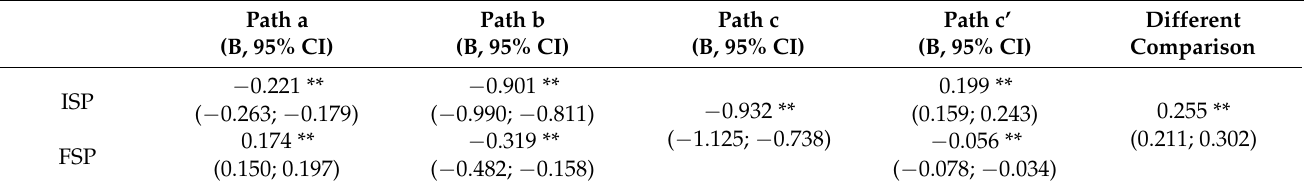
Table 3. Mediation of effect of place of residence on cognitive function through informal social partic- ipation and formal participation. ISP: informal social participation; FSP: formal social